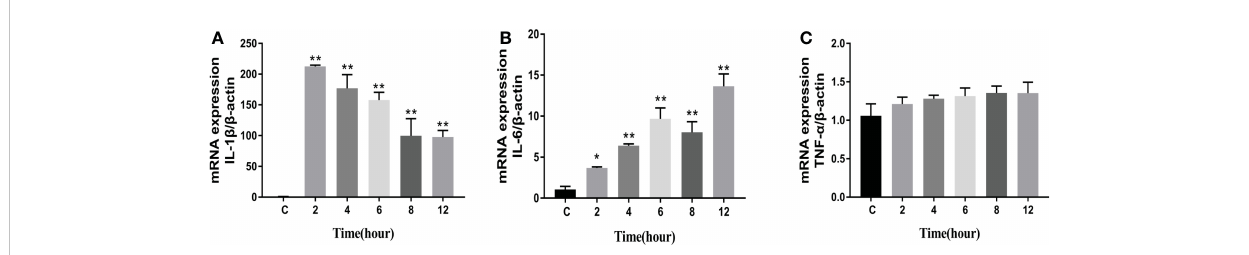
FIGURE 15 Expression level of pro-in fl ammatory factors. (A) IL-1 b , (B) IL-6, and (C) TNF- a levels. Data are presented as mean ± SD of three independent experiments. * P <0.05; ** P <0.01, compared with the control